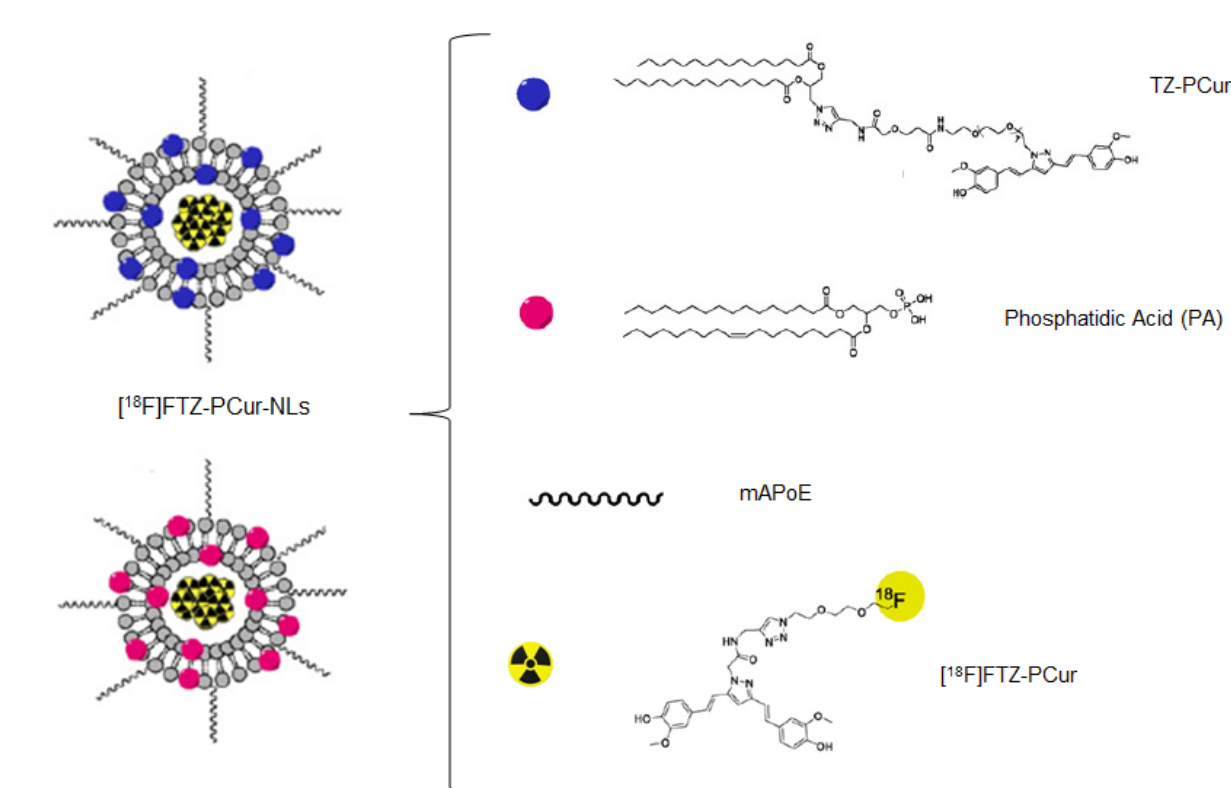
Figure 3. Scheme of functionalised NLs embedding [ 18 F]FTZ-PCur derivative. The figure has been obtained by modifying Figure 1 in reference [39]. Reprinted with permission from [39]. Copyright 2016